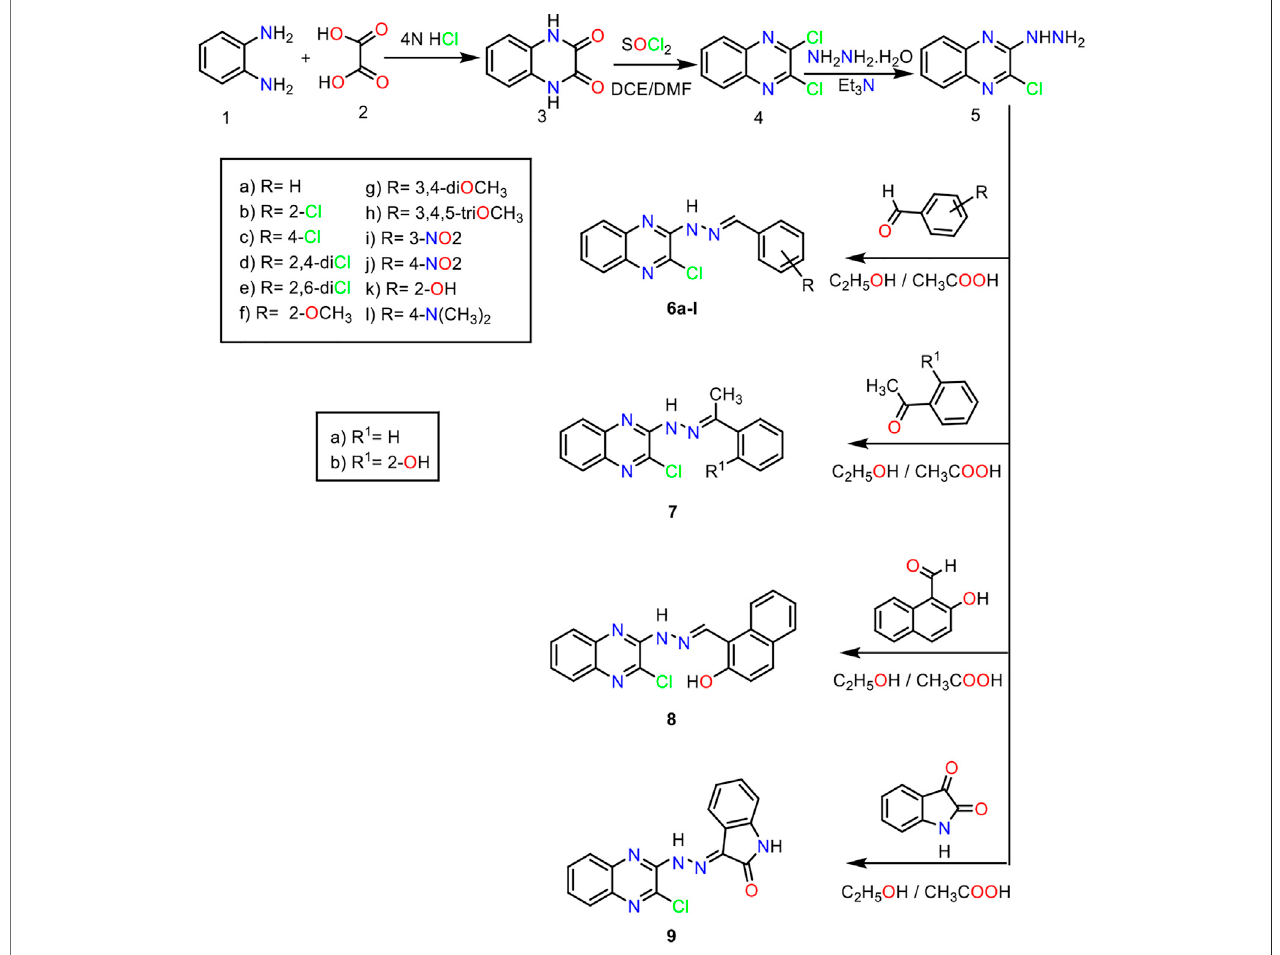
Scheme 1 | General procedure for the synthesis of compounds 6 a-l , 7 a,b , 8 , and 9 .